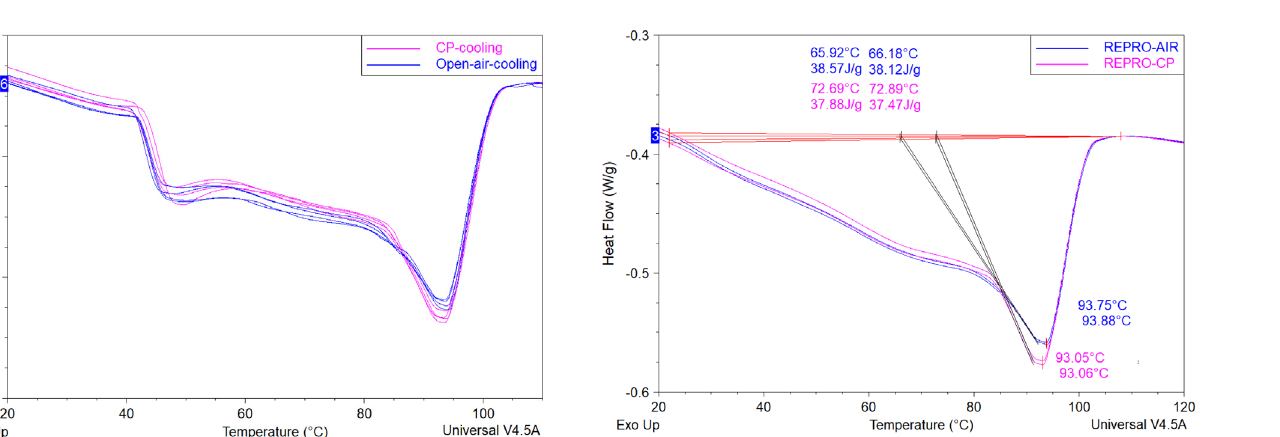
Fig. 5. DSC results for four samples of each cooling method. CP stands for Cooling Press.